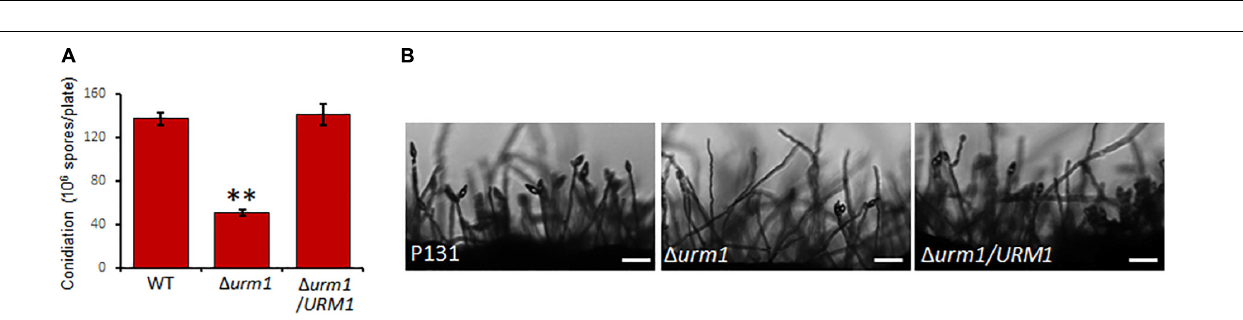
FIGURE 3 | URM1 is involved in vegetative growth. (A) Colony morphology of the wild type P131, (cid:49) urm1 mutant and complemented strains were observed on oatmeal tomato agar (OTA) plates at 28 ◦ C for 5 days. (B) The colony diameters were measured and subjected to statistical analysis. Error bars represent standard deviation and asterisk represents significant difference ( P < 0.05). (C) Cell length of the hyphae tips in the wild type P131, (cid:49) urm1 mutant and complemented strains. The triangles indicate septa between cells.